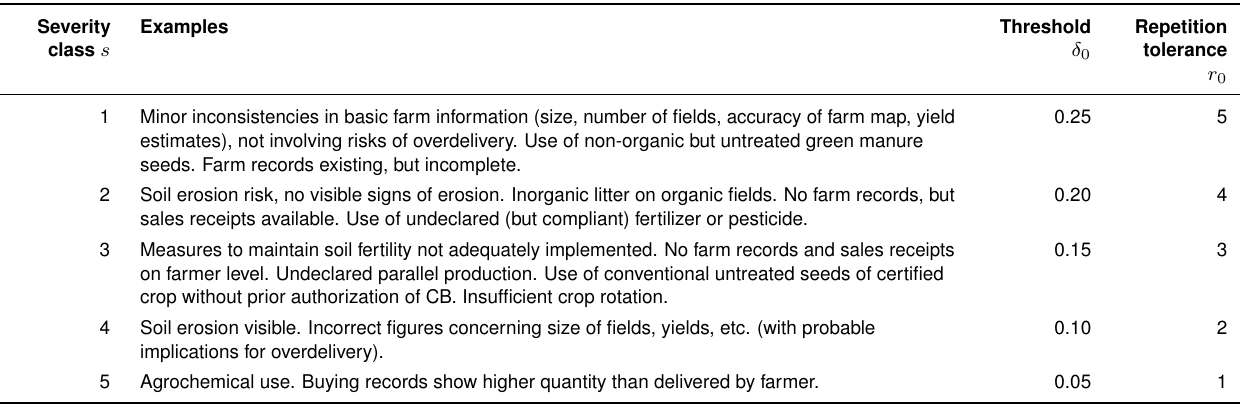
Table 3. Severity classes of NCs, examples, the corresponding thresholds δ 0 and repetition tolerances r 0